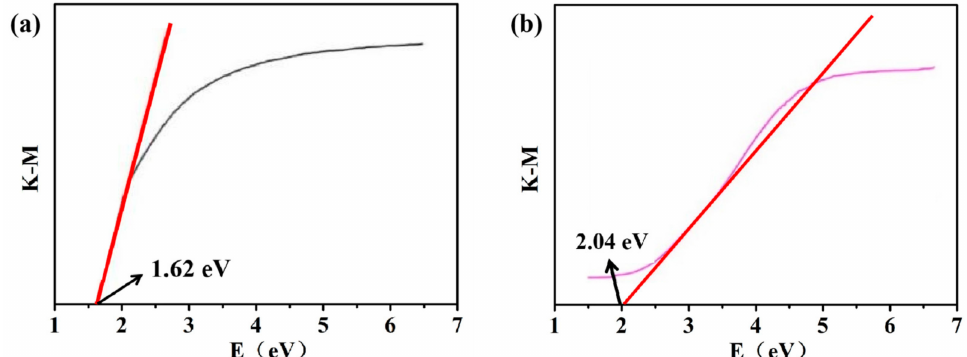
Figure 4. ( a ) Calculation diagram of band gap energy of catalyst 1 (The black line is the absorption curve of catalyst 1 , the red line is the tangent at the approximate linear in the absorption curve, and the intersection of the tangent line and the X-axis is the band gap value); and ( b ) calculation diagram of band gap energy of catalyst 2 (The pink line is the absorption curve of catalyst 2 , the red line is the tangent at the approximate linear in the absorption curve, and the intersection of the tangent line and the X-axis is the band gap